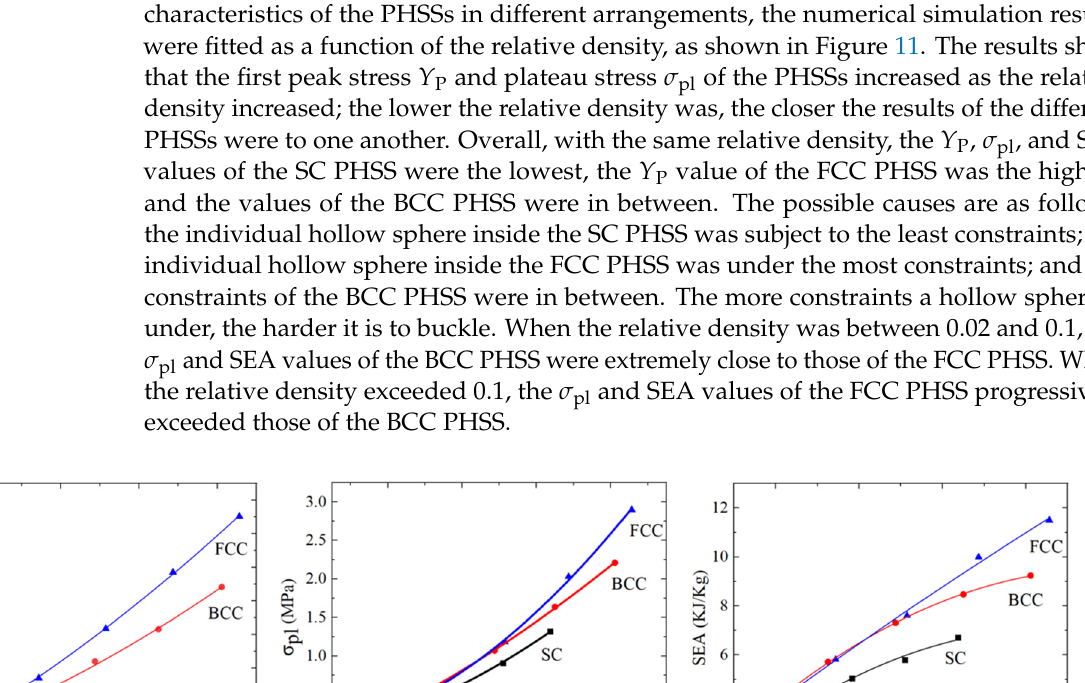
Figure 10. Deformations of SC structure with the ( a ) smallest and ( b ) largest wall thicknesses at a strain of 43%; deformations of BCC structure with the ( c ) smallest and ( d ) largest wall thicknesses at a strain of 37%; deformations of FCC structure with the ( e ) smallest and ( f ) largest wall thick- nesses at a strain of 44%.